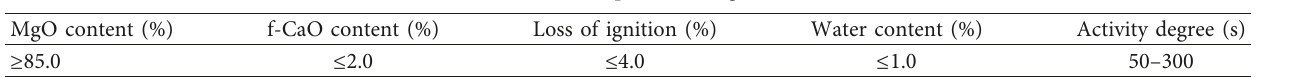
Table 3: Properties of MgO.